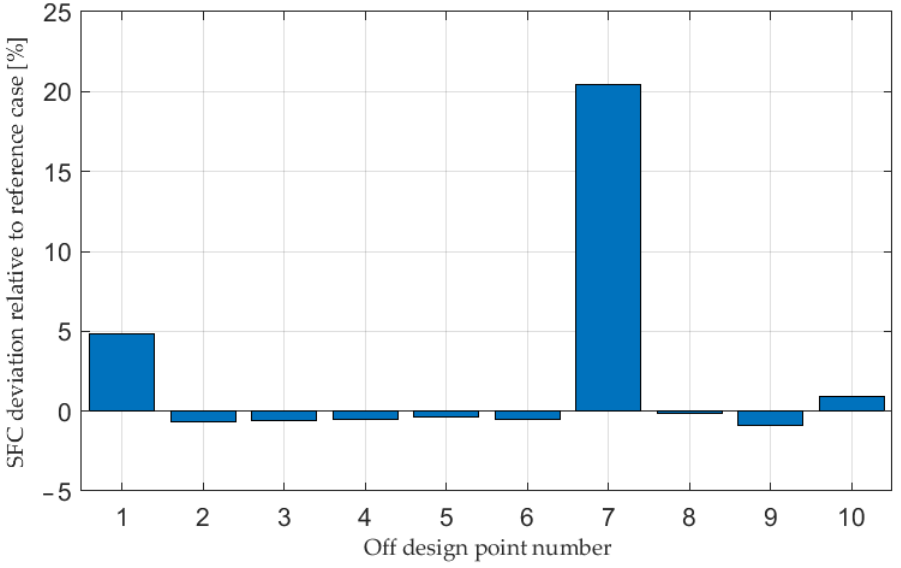
Figure 6. SFC deviation with HPT power extraction compared to the reference case.